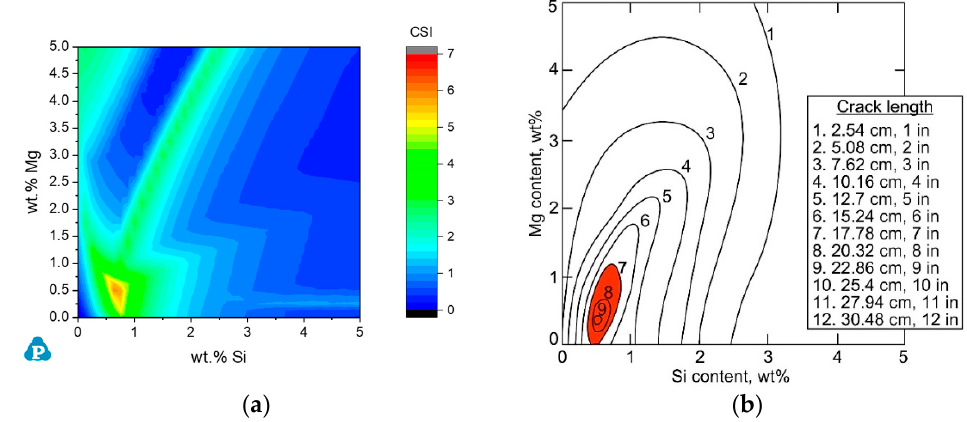
Figure 4. Al-Mg-Si cracking susceptibility maps: ( a ) by improved Scheil model considering back diffusion in the solid under the cooling rate of 20 °C/s and ( b ) experimentally tested data [55] (Reprinted with permission from ref. [24]. Copyright 2017 Elsevier).